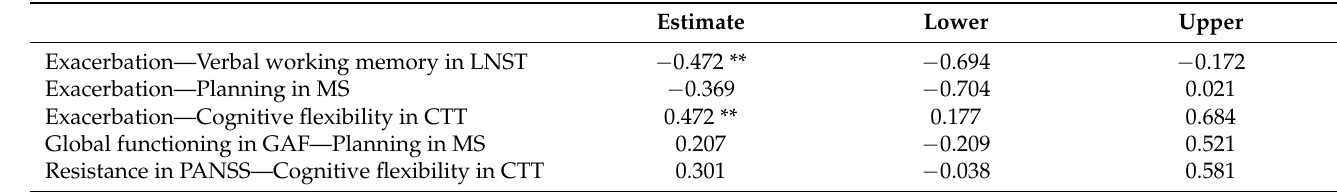
Table 5. Standardized regression weights for relations between clinical factors, psychopathological symptoms, and different aspects of executive functions in DS patients.